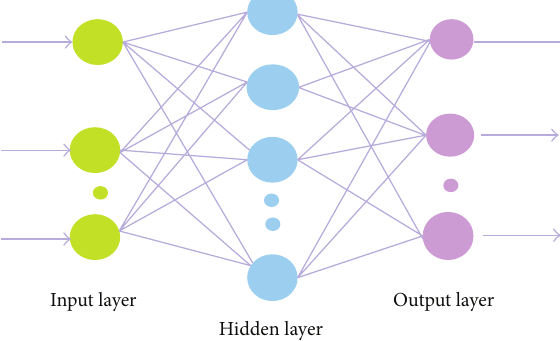
Figure 1: The topology of the BP neural